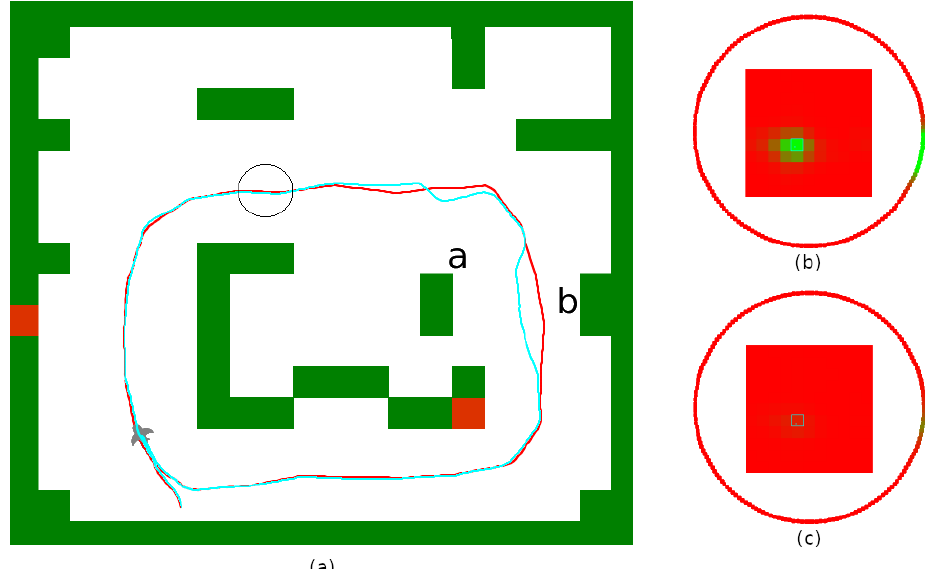
Figure 14. Robustness to environmental changes: ( a ) repeat mode in a modified environment. Despite the environment changes, the trajectory (cyan) remains close from the one in the initial environment (red). We observe that corner ( a ) and wall ( b ), which were moved but are still close to original position, disrupt the position estimation in the grid cell module, causing deviations in the trajectory. Figures ( b , c ) show the grid cells (square) and head direction cells (circle) activity in ( b ) reference and ( c ) modified environments at the position marked with a circle: despite a very weak activity, the cells can still estimate the correct position and